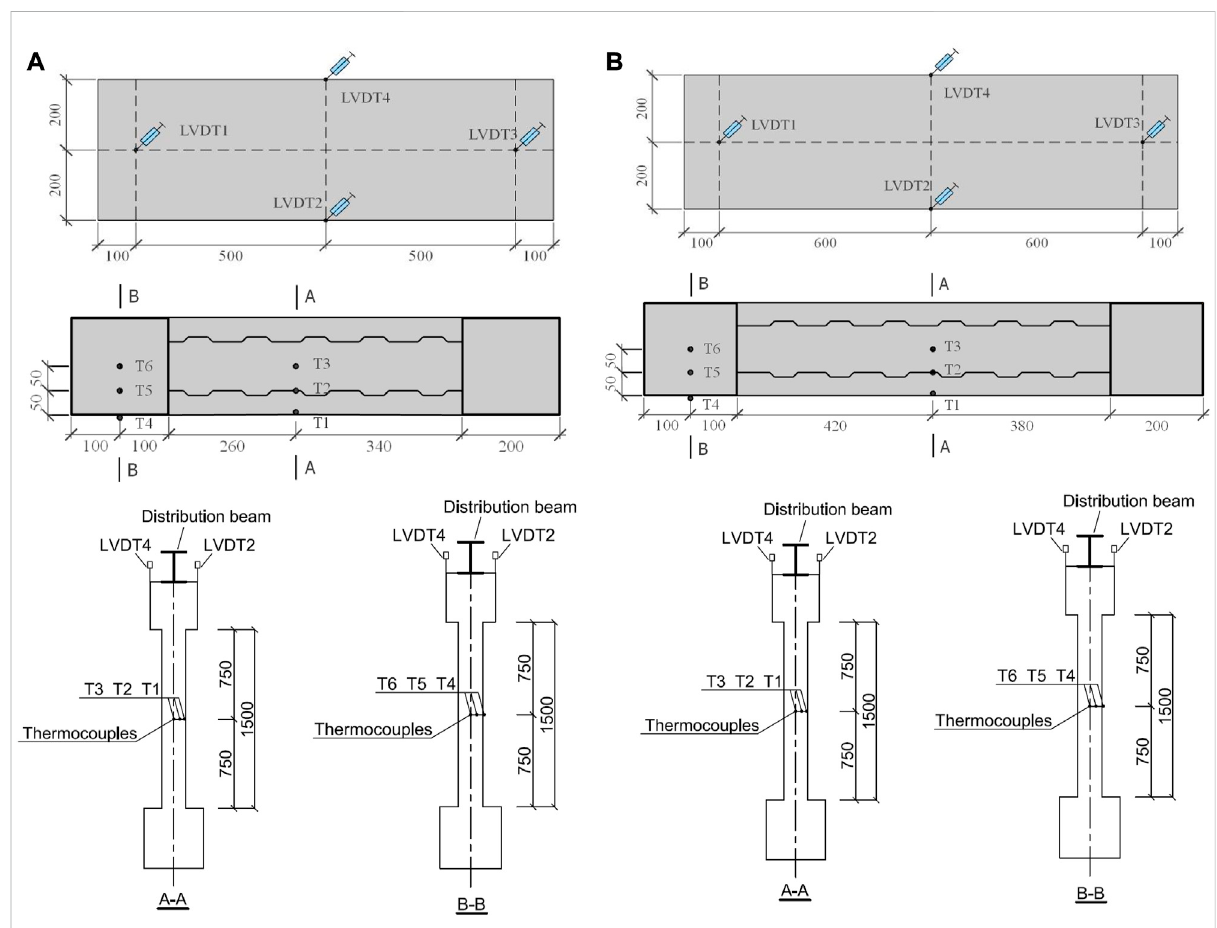
FIGURE 6 Arrangements for instrumentations of (A) SW1 and SW2; (B) SW3 (unit: